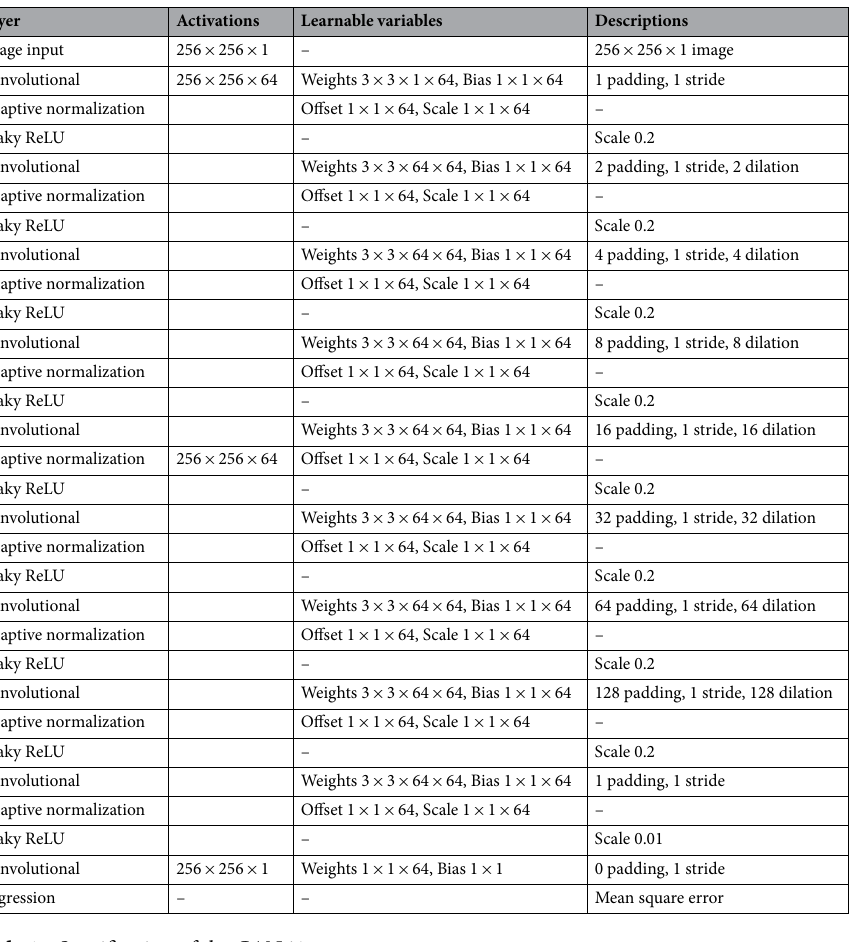
Table 1. Specification of the